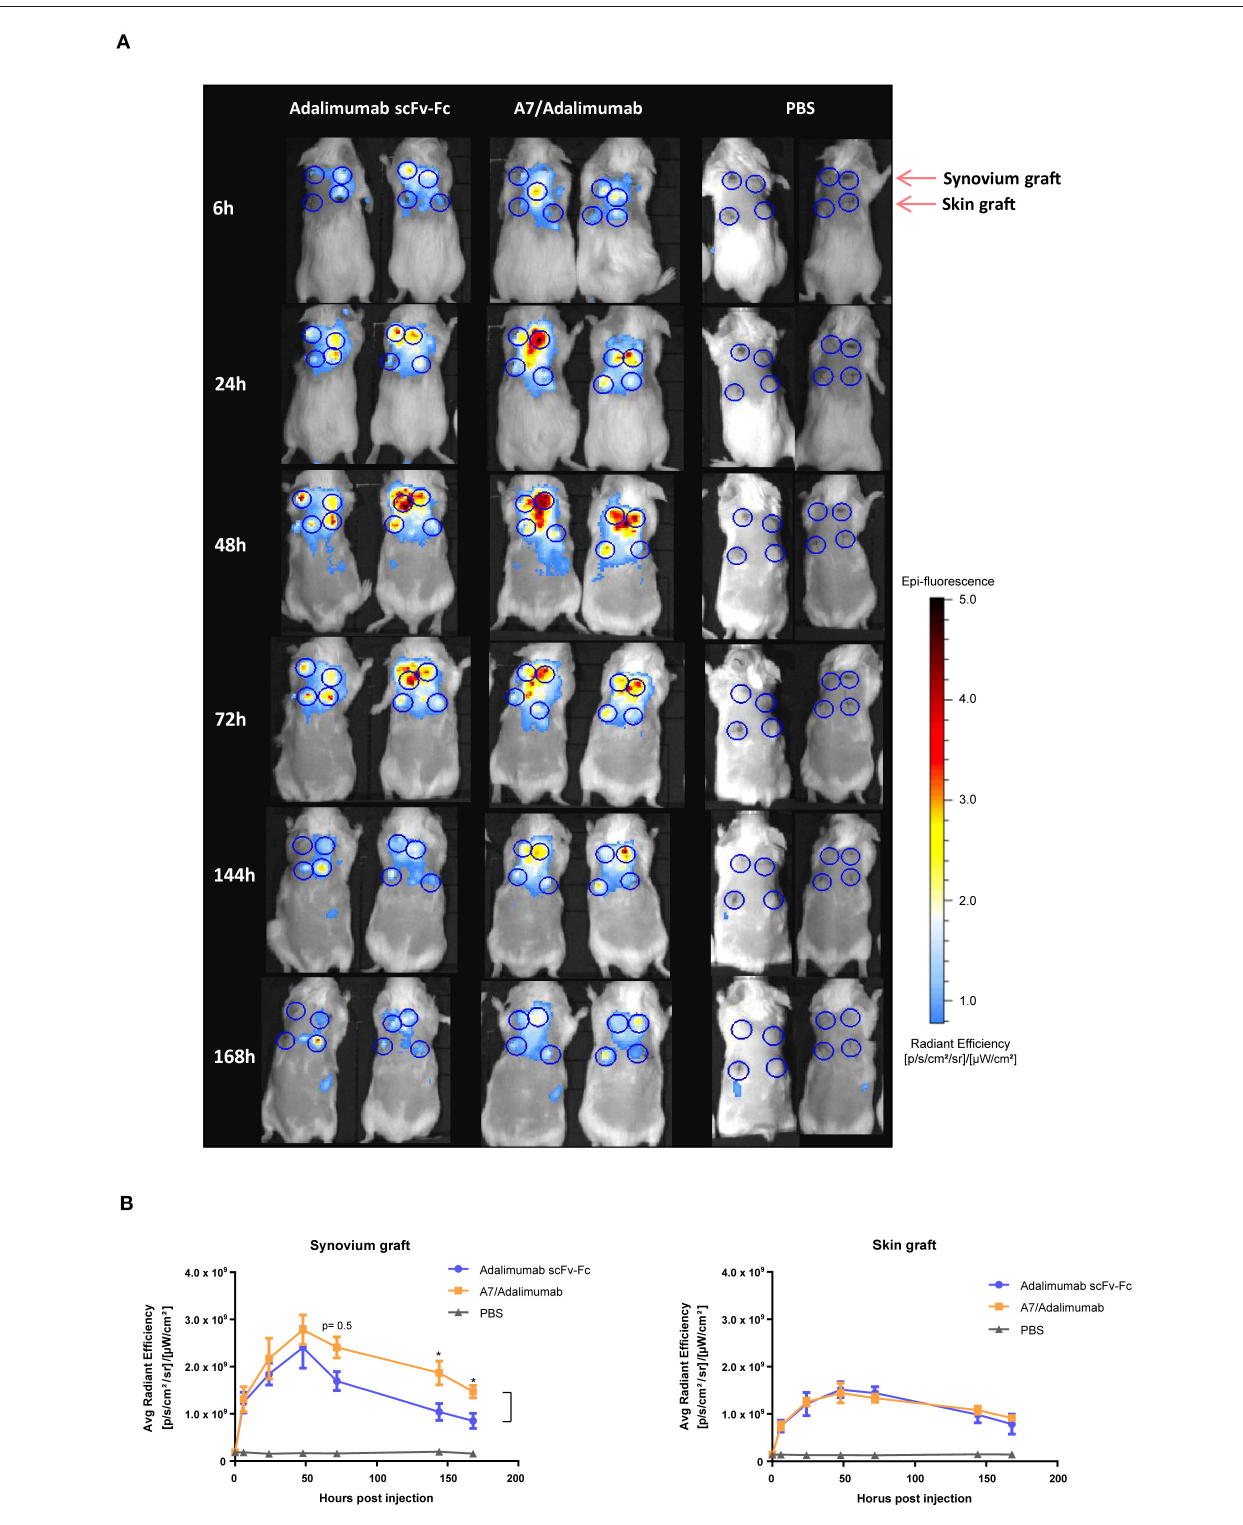
FIGURE 3 | In vivo localization in human synovium xenograft SCID mouse model. (A) SCID mice double grafted with the human arthritic synovium (top) ( n = 4) and human normal skin (bottom) ( n = 4) were injected intravenously with Cy5.5 conjugated antibody and imaged at 6, 24, 48, 72, 144, and 168h. As control, PBS was injected. Blue circles indicate graft location in fluorescence images. (B) Quantification of average radiant efficiency in the region of interest encompassing the graft location shows an increased intensity that correlates with the amount of Cy5.5 conjugated antibody accumulated in the tissue. Values were expressed as mean ± SEM. Mann–Whitney non-parametric test (* p <